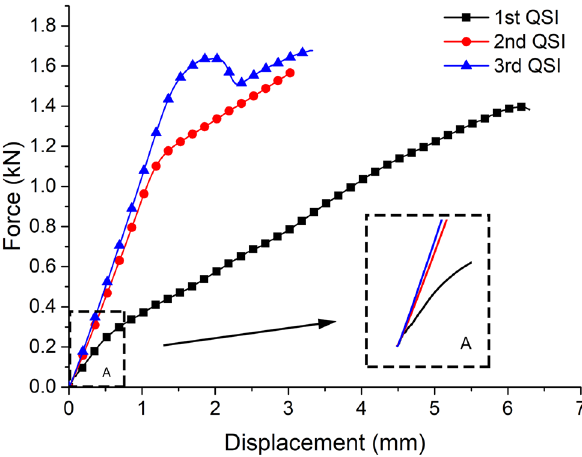
Figure 7: Force – displacement curves of specimen subjected to RQSI.